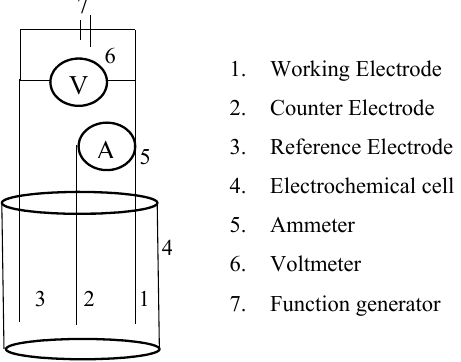
Figure 1. General electrochemical cell set-up. Typically, a potentiostat is used as the ammeter, voltmeter, and function